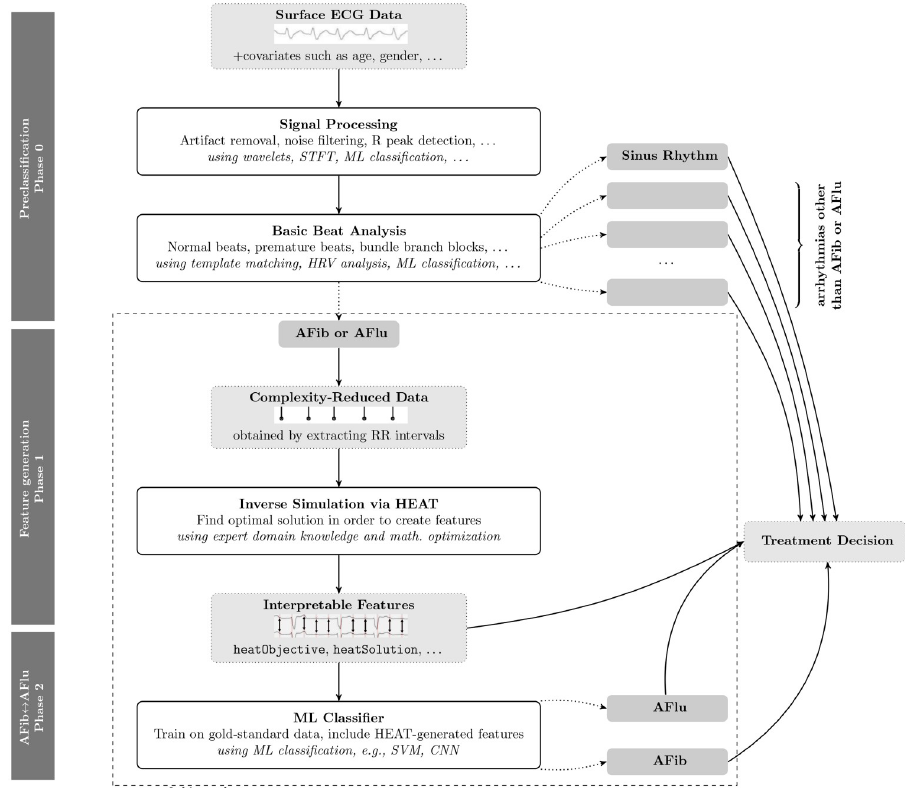
Fig 1. Visualization of our workflow from surface ECG to decision support for treatment. We focus on phases 1 (generation of physiologically interpretable features) and 2 (using them for AFib $ AFlu classification), thus assuming a pre-classification of all